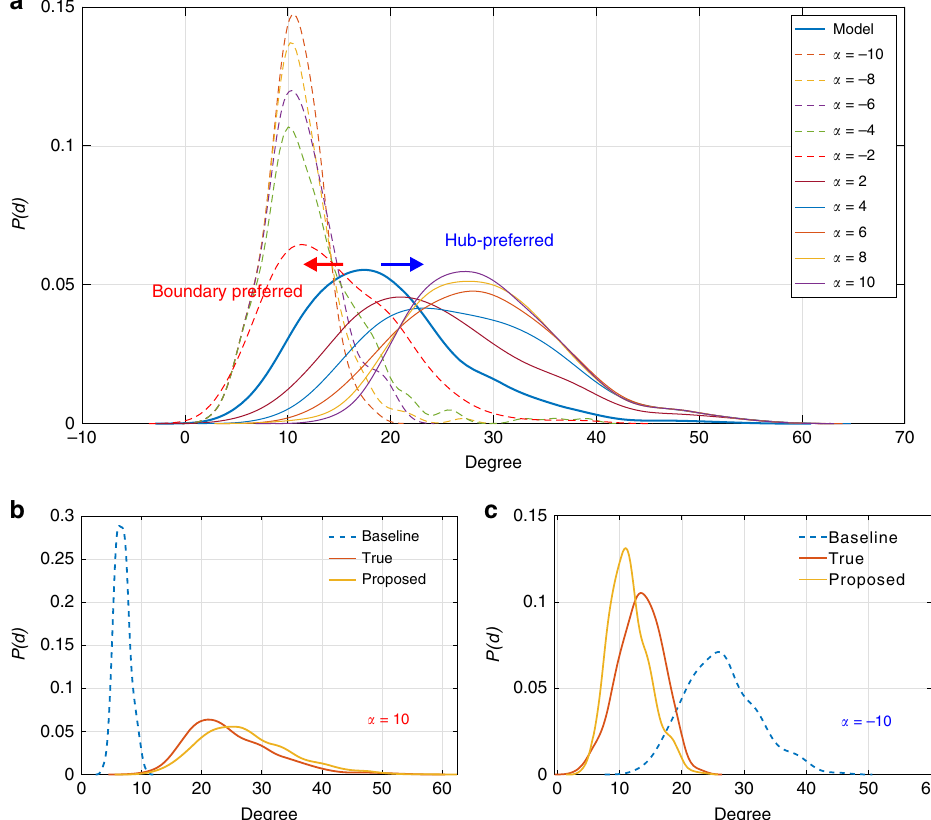
Fig. 3 Degree distribution analysis. a Reshaped degree distribution of the latent network structure. b , c Capability to reconstruct the missing network structure under hub-prioritized intervention ( α = 10, b ) or boundary-prioritized intervention ( α = − 10, c ) with 45% of nodes